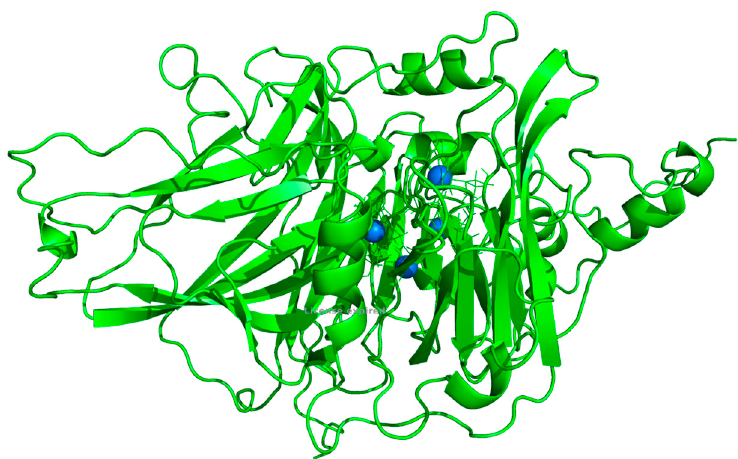
Figure 4. Model of Af _AO1: Proposed 3D-structure of Af _AO1 based on the structure of the ascorbate oxidase from Cucurbita pepo var. melopepo (PDB Code: 1ASQ [42]). Copper atoms are displayed in blue and coordinating residues are represented as